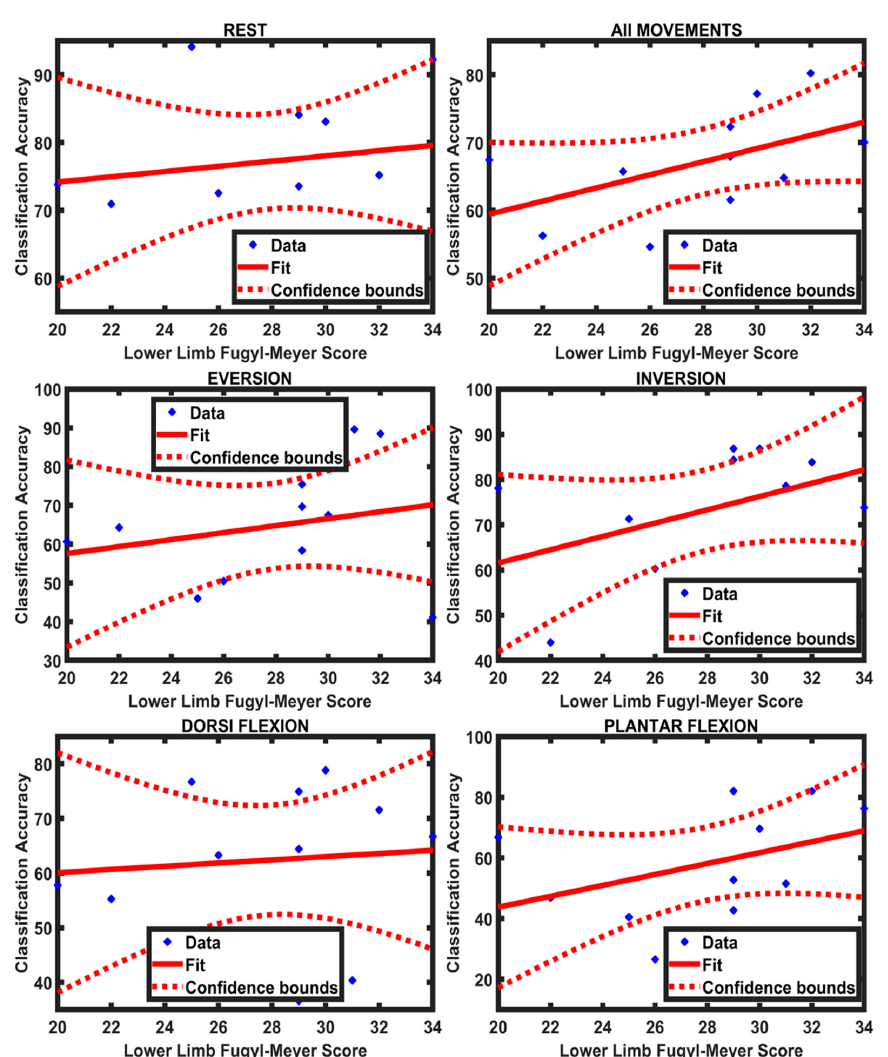
Figure 8. A regression line fitted to the participants’ data of Limb Fugl ‐ Meyer score and their classification accuracies (ANN) of individual movements and all movements combined.